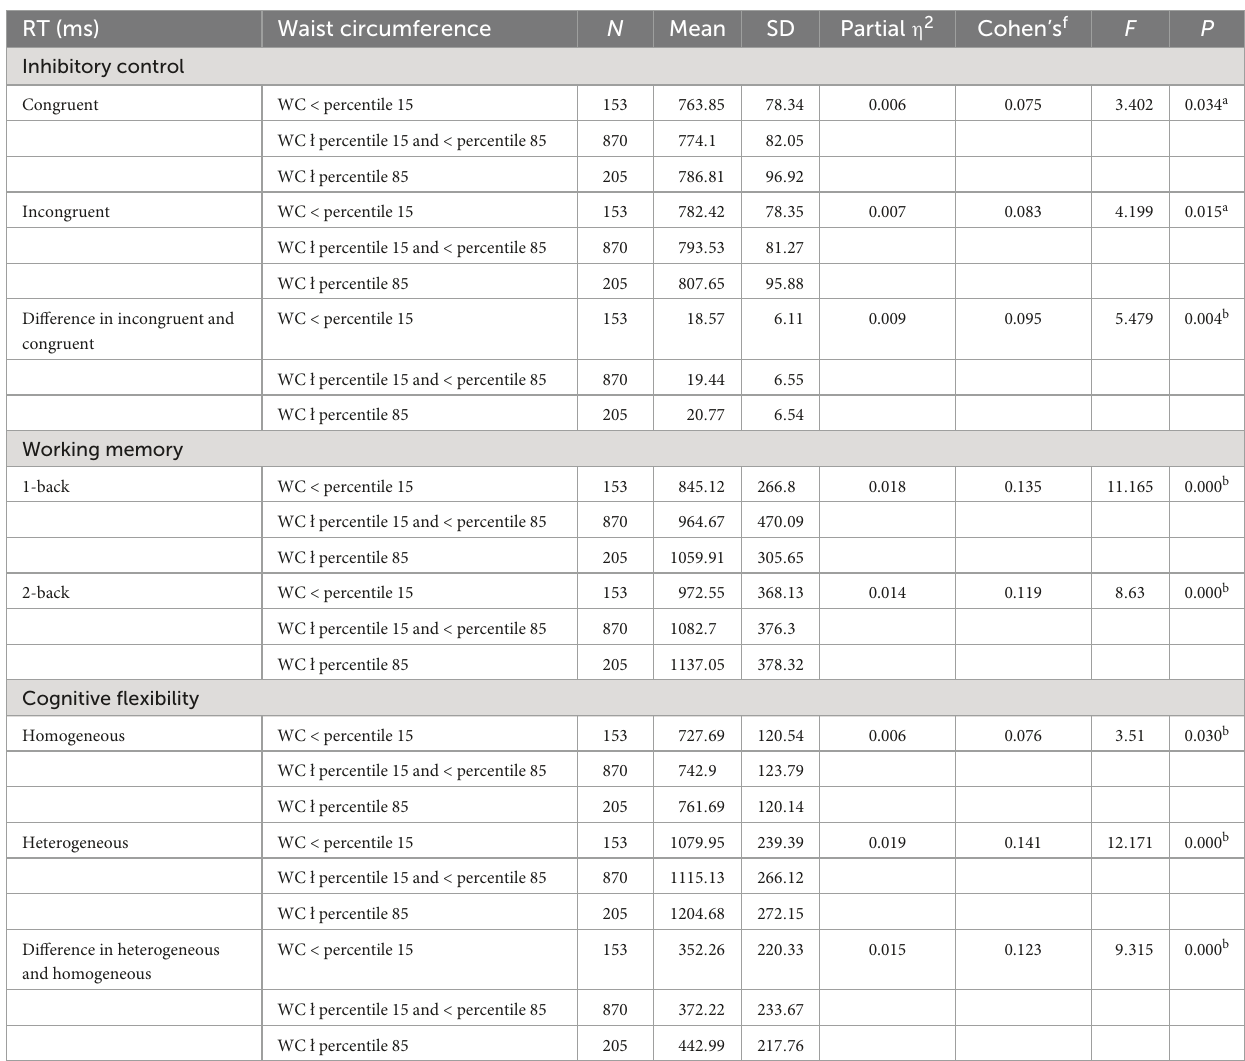
TABLE 2 Status of executive function by WC percentile